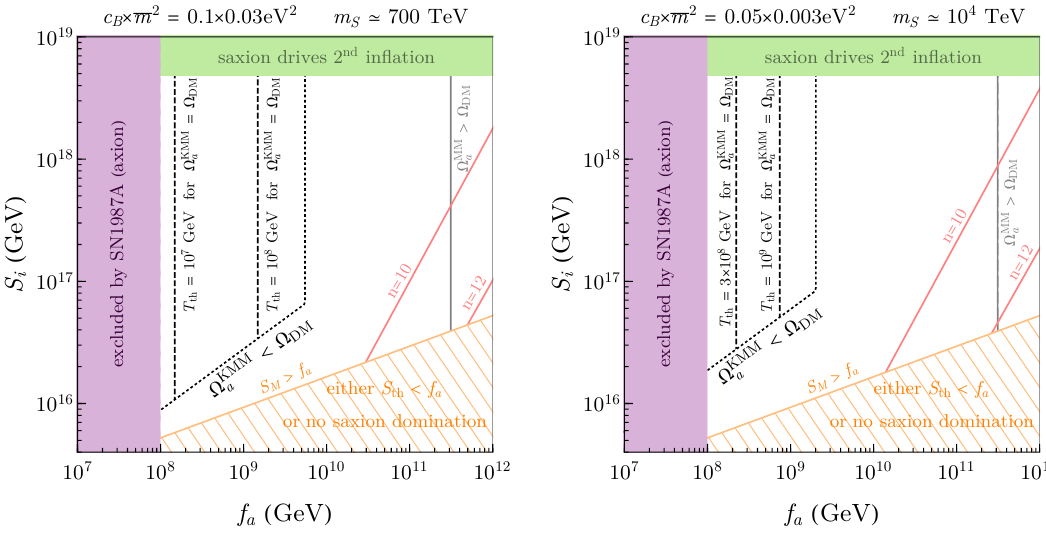
Figure 6 . Parameter space compatible with the observed baryon asymmetry for nearly quadratic potentials in the case with entropy production from saxion domination for N DW = 1 . Values of m S that yield the observed baryon asymmetry are shown at top. We fix (cid:15) = 0 . 25 , which affects the black (both solid and dotted) and pink